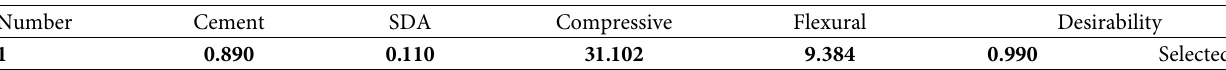
Table 24: Optimization